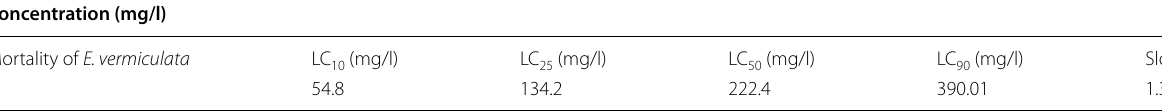
Table 1 Molluscicidal activity of chitosan against adult Eobania vermiculata snails (24 h. exposure) Concentration (mg/l) Mortality of E.